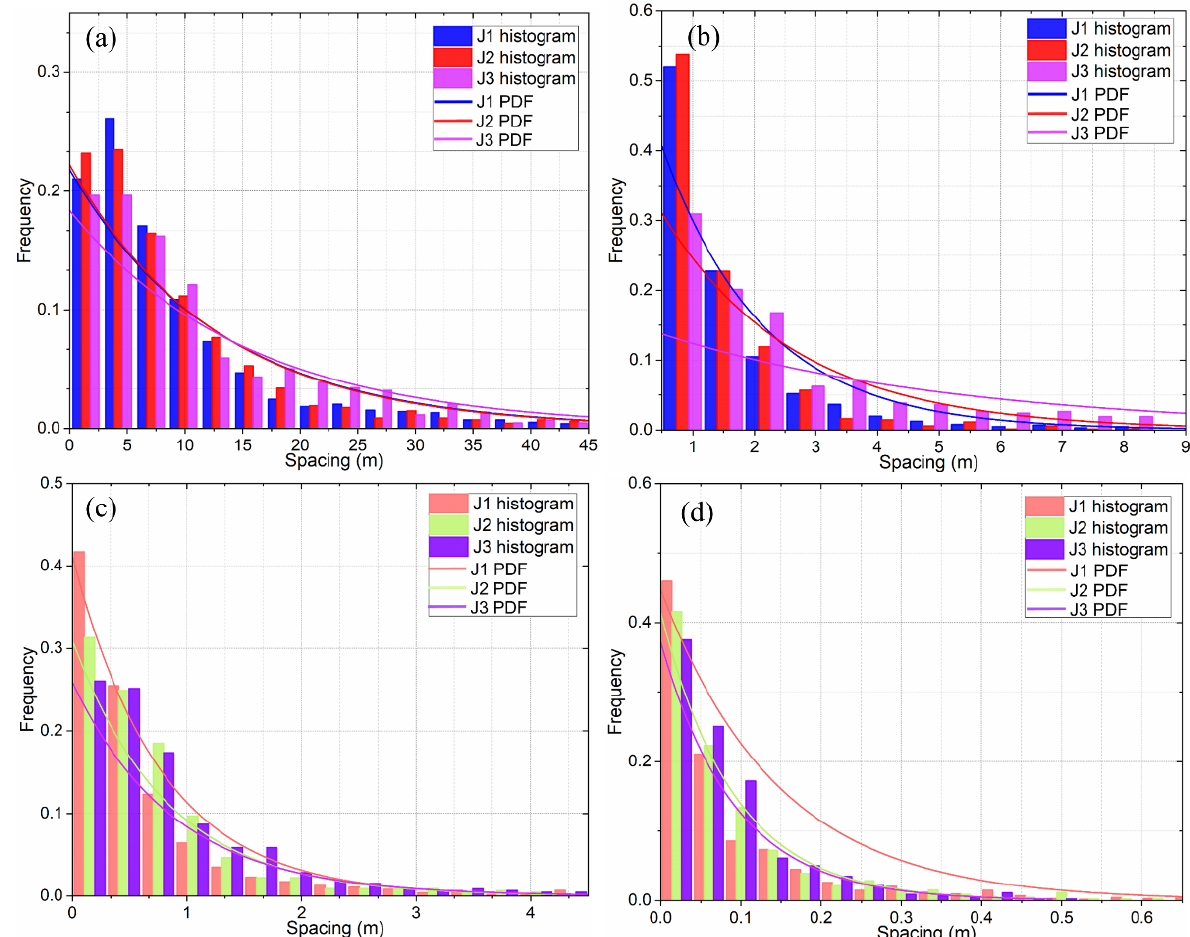
Figure 9. ( a , c ) Set spacing histogram of non-persistent statistics from ALS and SfM points; ( b , d ) set spacing histogram of fully persistent statistics from ALS and SfM points (with fitted negative expo- nential distribution).